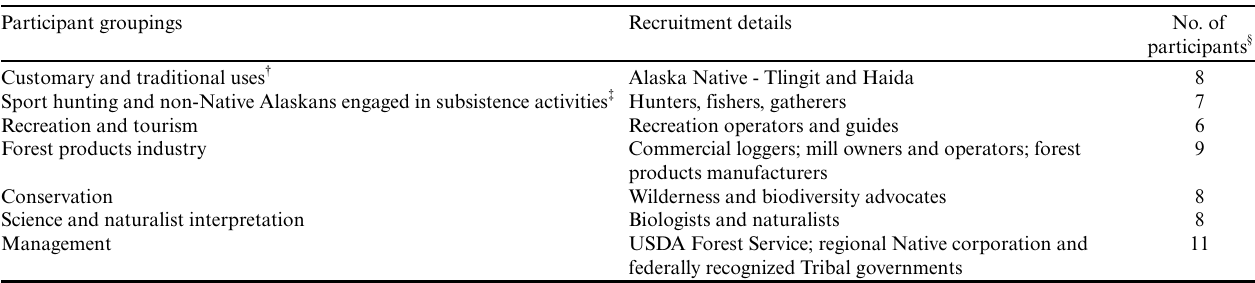
Table 1 . Groupings used to guide participant recruitment of forest users (n = 34) and managers (n = 11). Participant